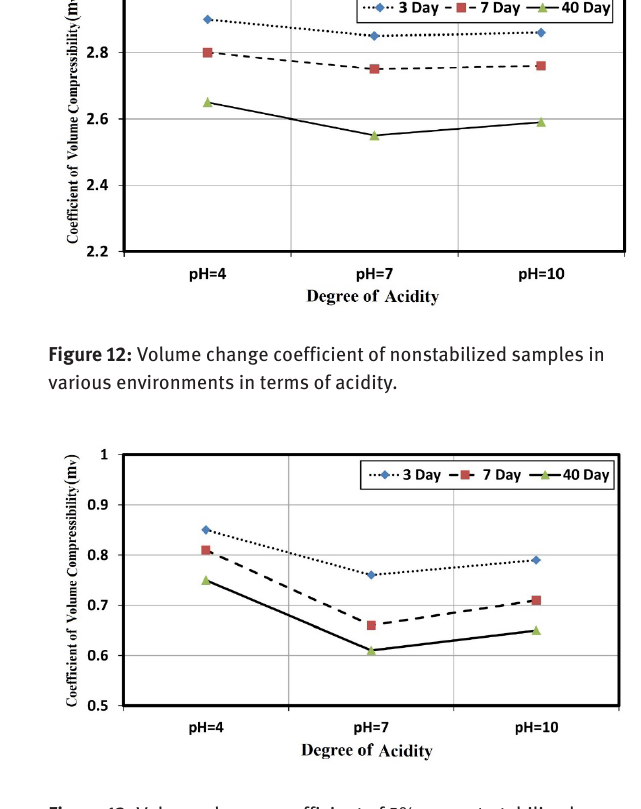
Figure 13: Volume change coefficient of 5% cement-stabilized samples in various environments in terms of